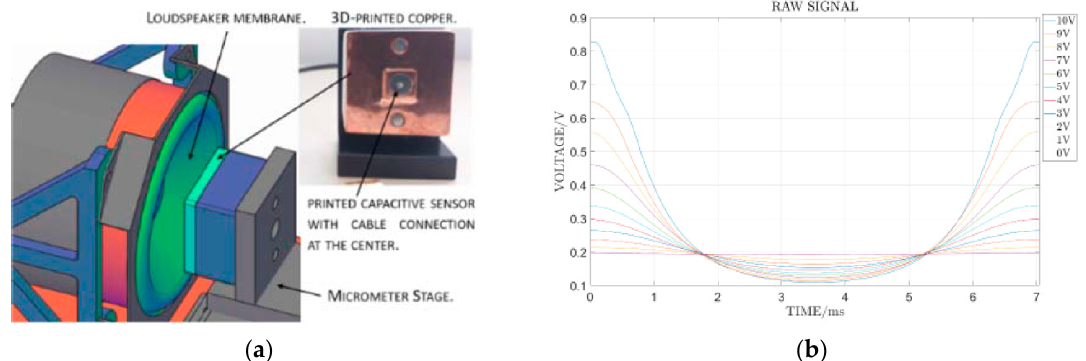
Figure 2. Illustration of the demonstrator setup and measurement results. ( a ) Demonstrator-setup developed to show the resolution capabilities of the printed system. ( b ) Measurement results with the demonstrator and the printed capacitive sensor mounted in a distance of d sens = 1 mm.